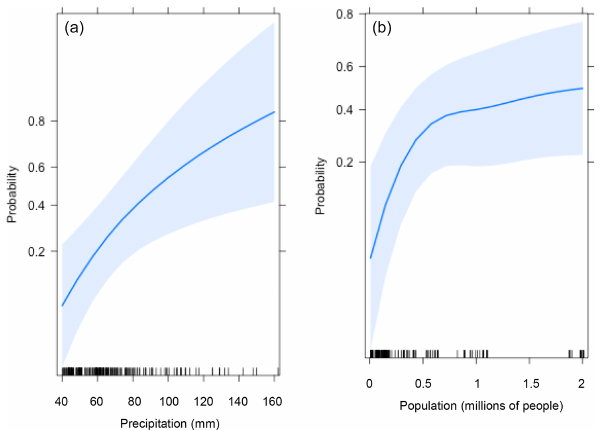
Figure 4. Effect of the explanatory variables ( a : mean precipitation recorded in 24h; b : total population of the basin) on the probability of exceeding the 70th percentile of damage in Catalonia. The solid line indicates the best estimate, while the shaded blue bands indicate the 95% confidence interval. The black marks at the bottom of each graph represent the values of the independent variable for each flood case.